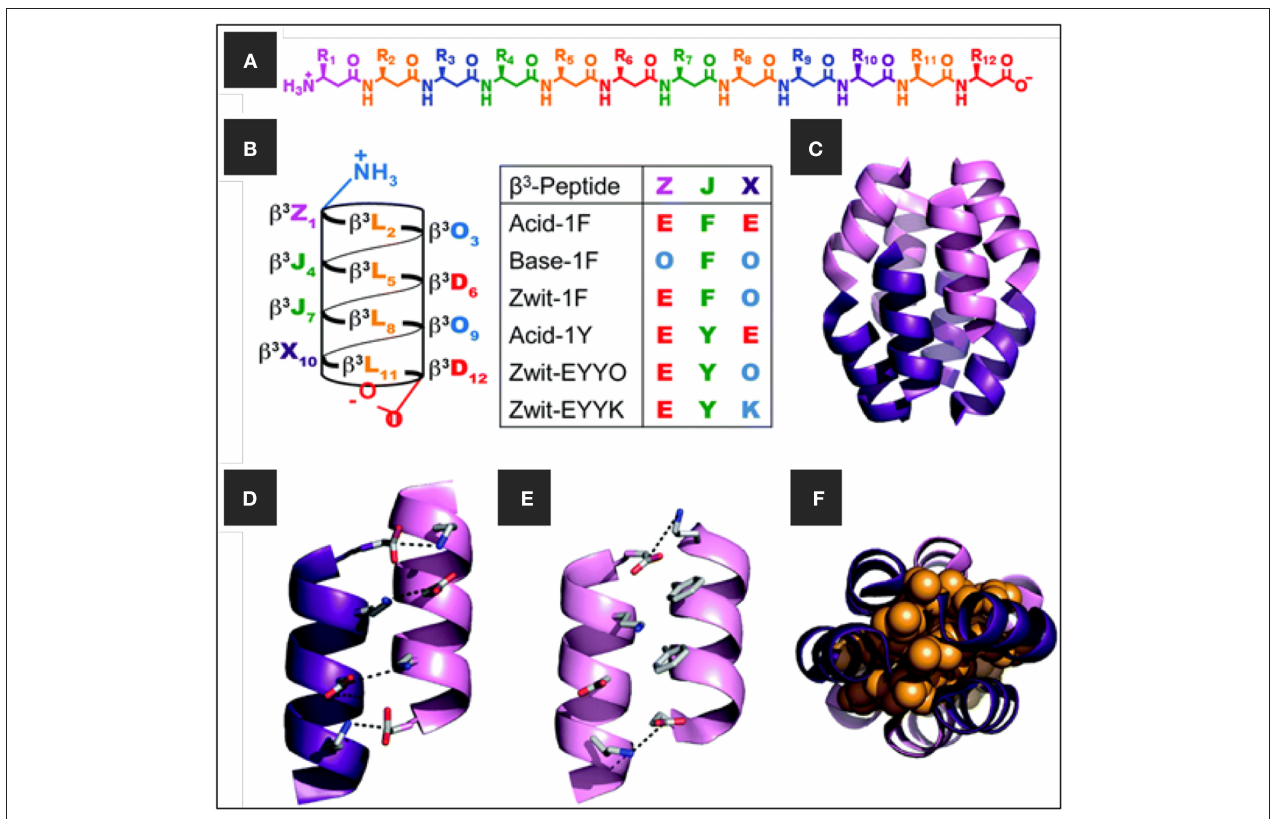
FIGURE 3 | (A) Chemical structure of β -dodecapeptide, (B) helical net representation of a β -dodecapeptide folded into a 14-helix with the different β 3 -peptide sequences (C) β -peptide bundle, the homo-octamer of Zwit-1F, (D,E) close-up view of salt-bridging interactions at the (D) anti-parallel and (E) parallel helical interfaces of Zwit-1F, and (F) space-filling model (orange) showing tight packing of β 3 -homoleucine side-chains in the Zwit-1F core. Adapted with permission from Daniels et al. (2007). Copyright 2007 American Chemical Society.